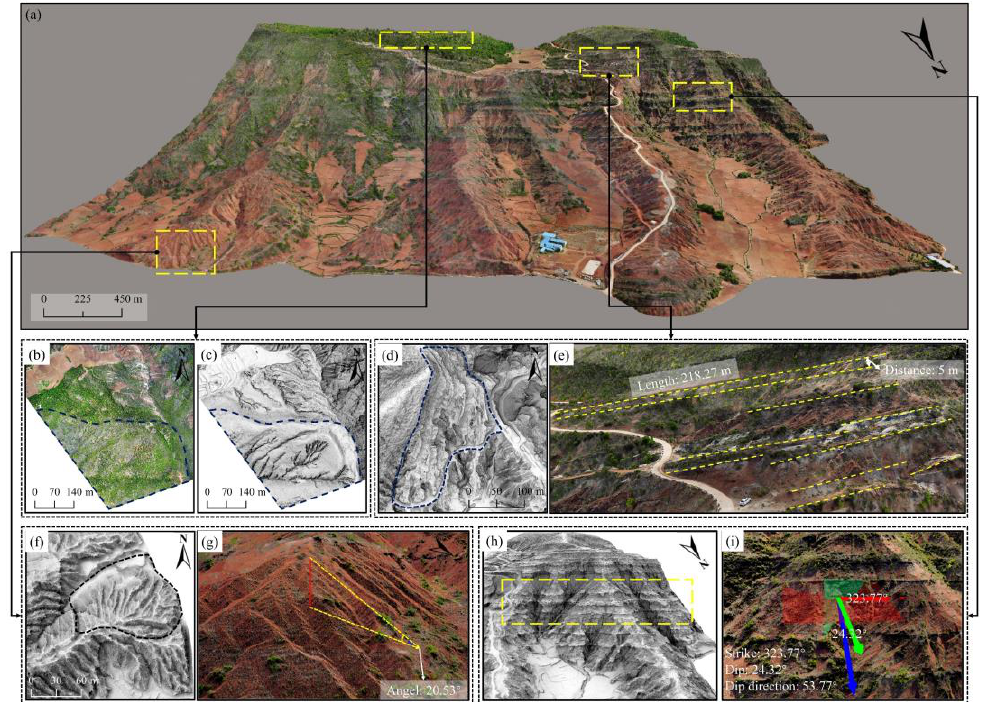
Figure 17. ( a ) A 3D model of the pit rim structure, ( b ) DOM of the gully inside the pit rim structure, ( c ) SVF visualization result of the gully, ( d ) SIM visualization result of the outcrop, ( e ) a 3D model of the outcrop’s geomorphological measurement, ( f ) SVF visualization results of the ridge end, ( g ) ridge slope measurement based on the LiDAR point-cloud, ( h ) SIM 3D bedding visualization results, and ( i ) bedding strike, dip and dip direction measurements based on the LiDAR point-cloud (the green arrow represents perpendicular to the strike line).